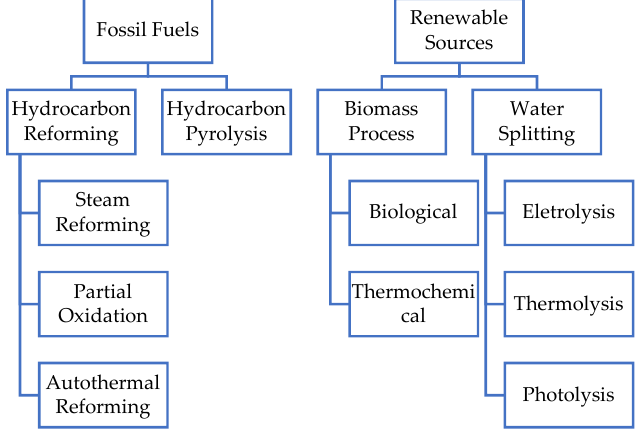
Figure 1. Hydrogen production methods [34].